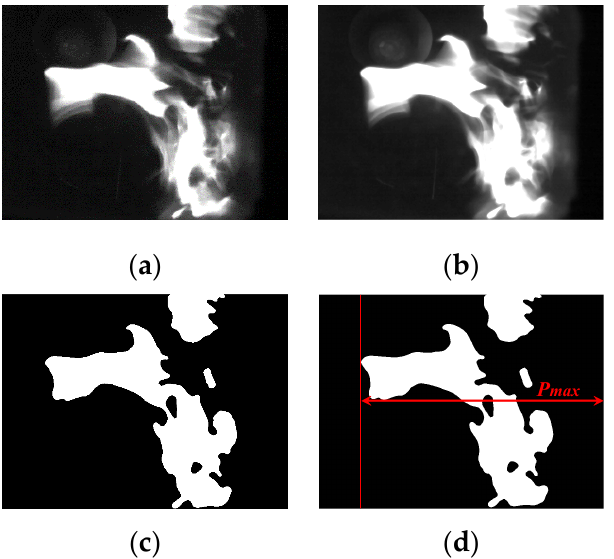
Figure 4. Analysis of the flame image: ( a ) The original image; ( b ) the image after median filter; ( c ) binarization of flame; and ( d ) the farthest pixel position of the flame.